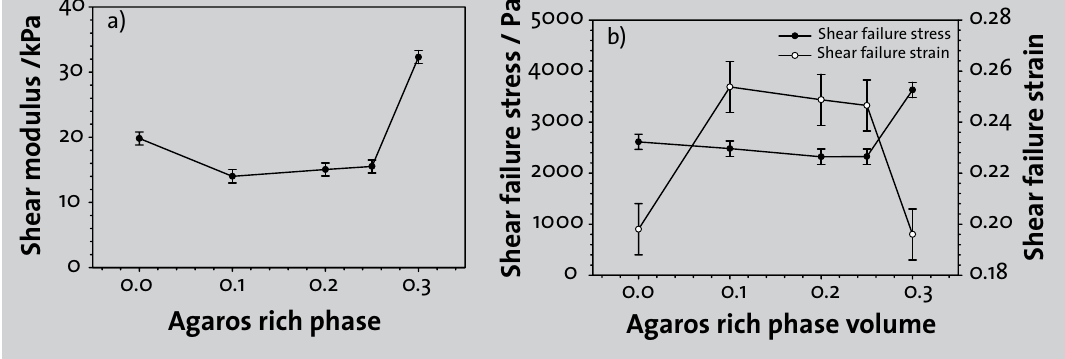
Figure 7: Effect of agarose rich phase volume on a) the shear modulus and b) the shear stress and strain at failure for maltodextrin/agarose composite gels. The rich phases were obtained from the phase separation of 12.5 % SA2 / 5 % Ag (Vane rheometer, shear rate: 0.05 s -1 , T : 10ºC). The error cup bars are those estimated for the maltodextrin rich phase (see Fig.